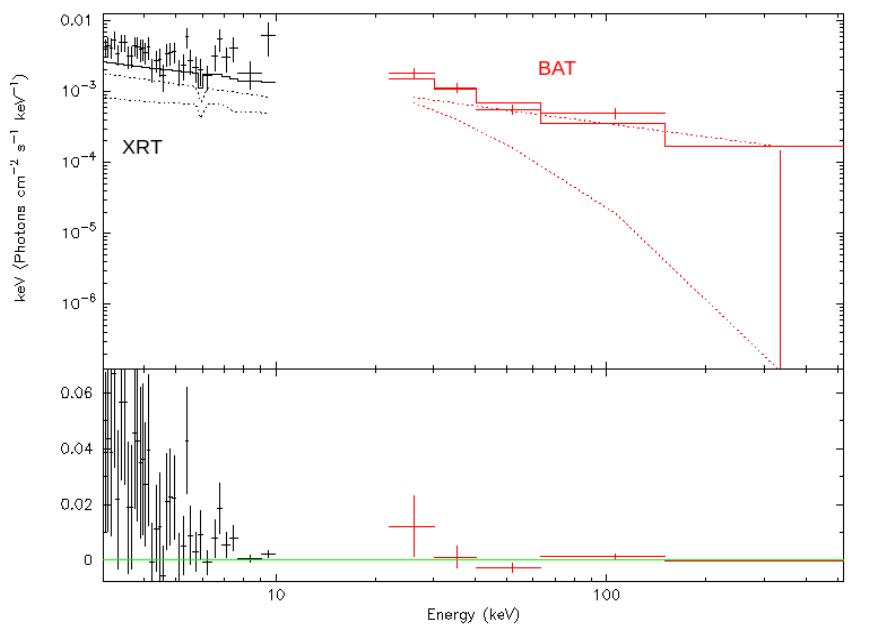
Figure A12. Unfolded SWIFT/XRT and SWIFT/BAT spectra of 3C 111 during 12th (December 2017) observational period and model. Above: all the spectra are shown by crosses; fitting curves are shown by solid lines; model components are shown by dotted lines; below: data residuals. During this period jet base emission was dominating over nuclear one (the jet base flux in 5–7 keV range was near as twice as higher than the nuclear one); emission in Fe-K α line was weak; also the tiny signs of the weak absorption line near 5.9 were